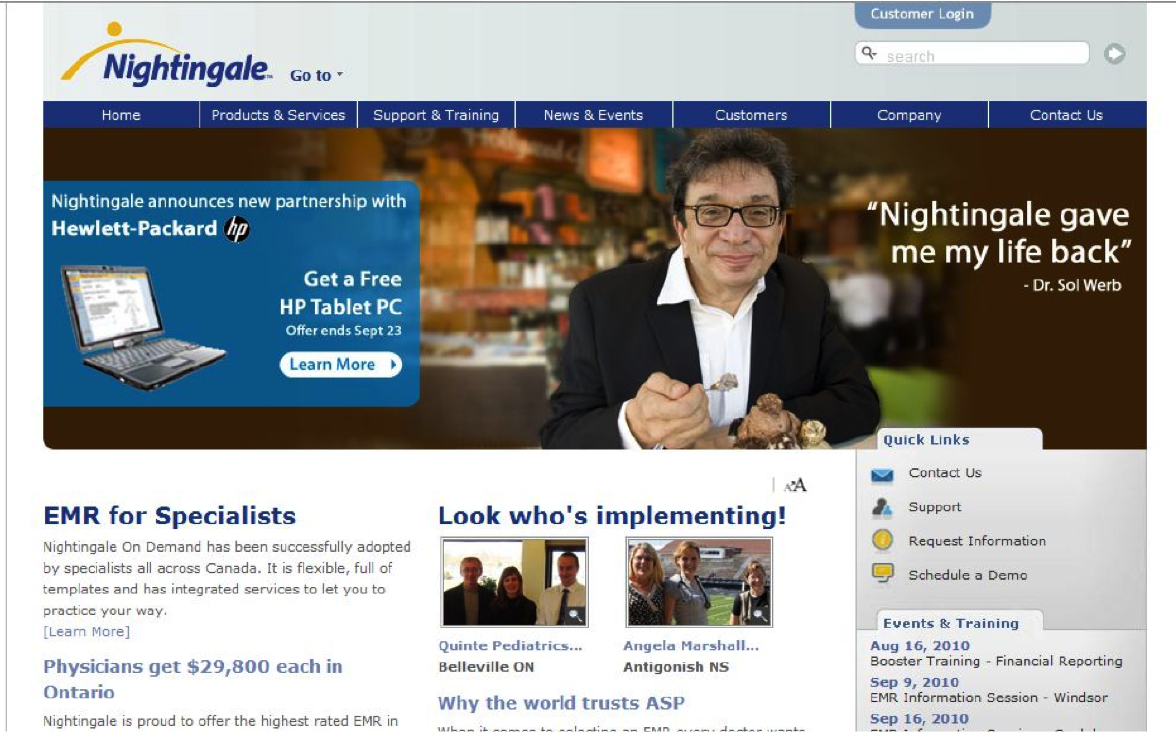
Figure 2. Nightingale On Demand (primary care). From: http://www.nightingalemd.ca; taken on August 25,